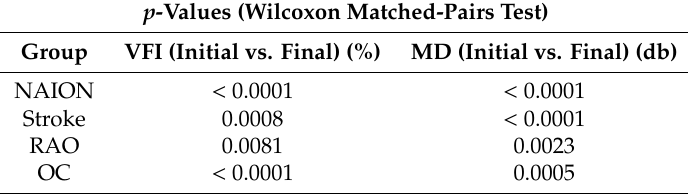
Table 6. P-values obtained for comparisons between initial and final values of VFI (%) and MD (db) of each group of